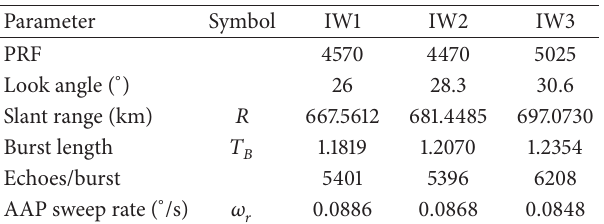
Table 2: Swath-dependent parameters and timeline optimized for the proposed